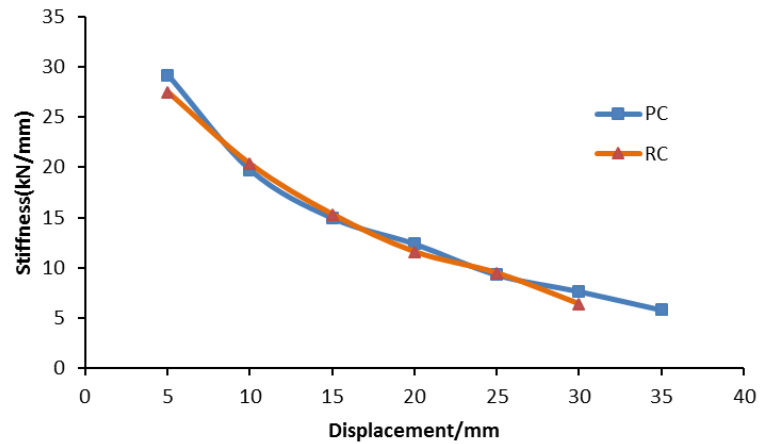
Figure 12. Stiffness curves.